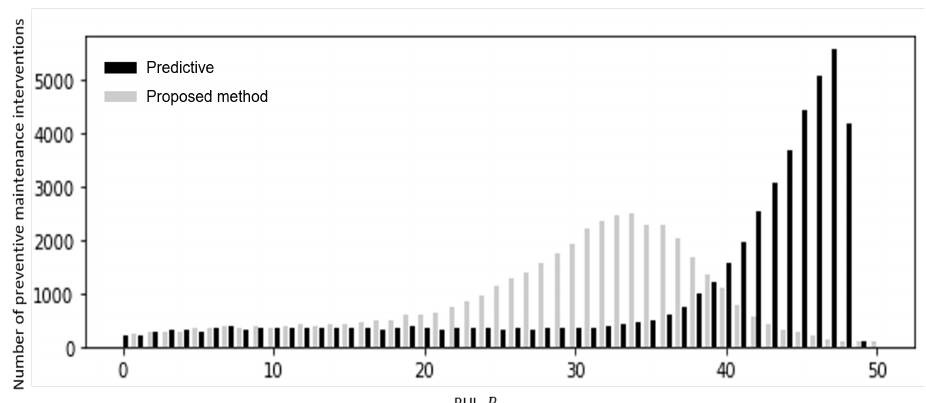
Figure 4. Number of maintenance interventions at different RUL values, with C = 1.